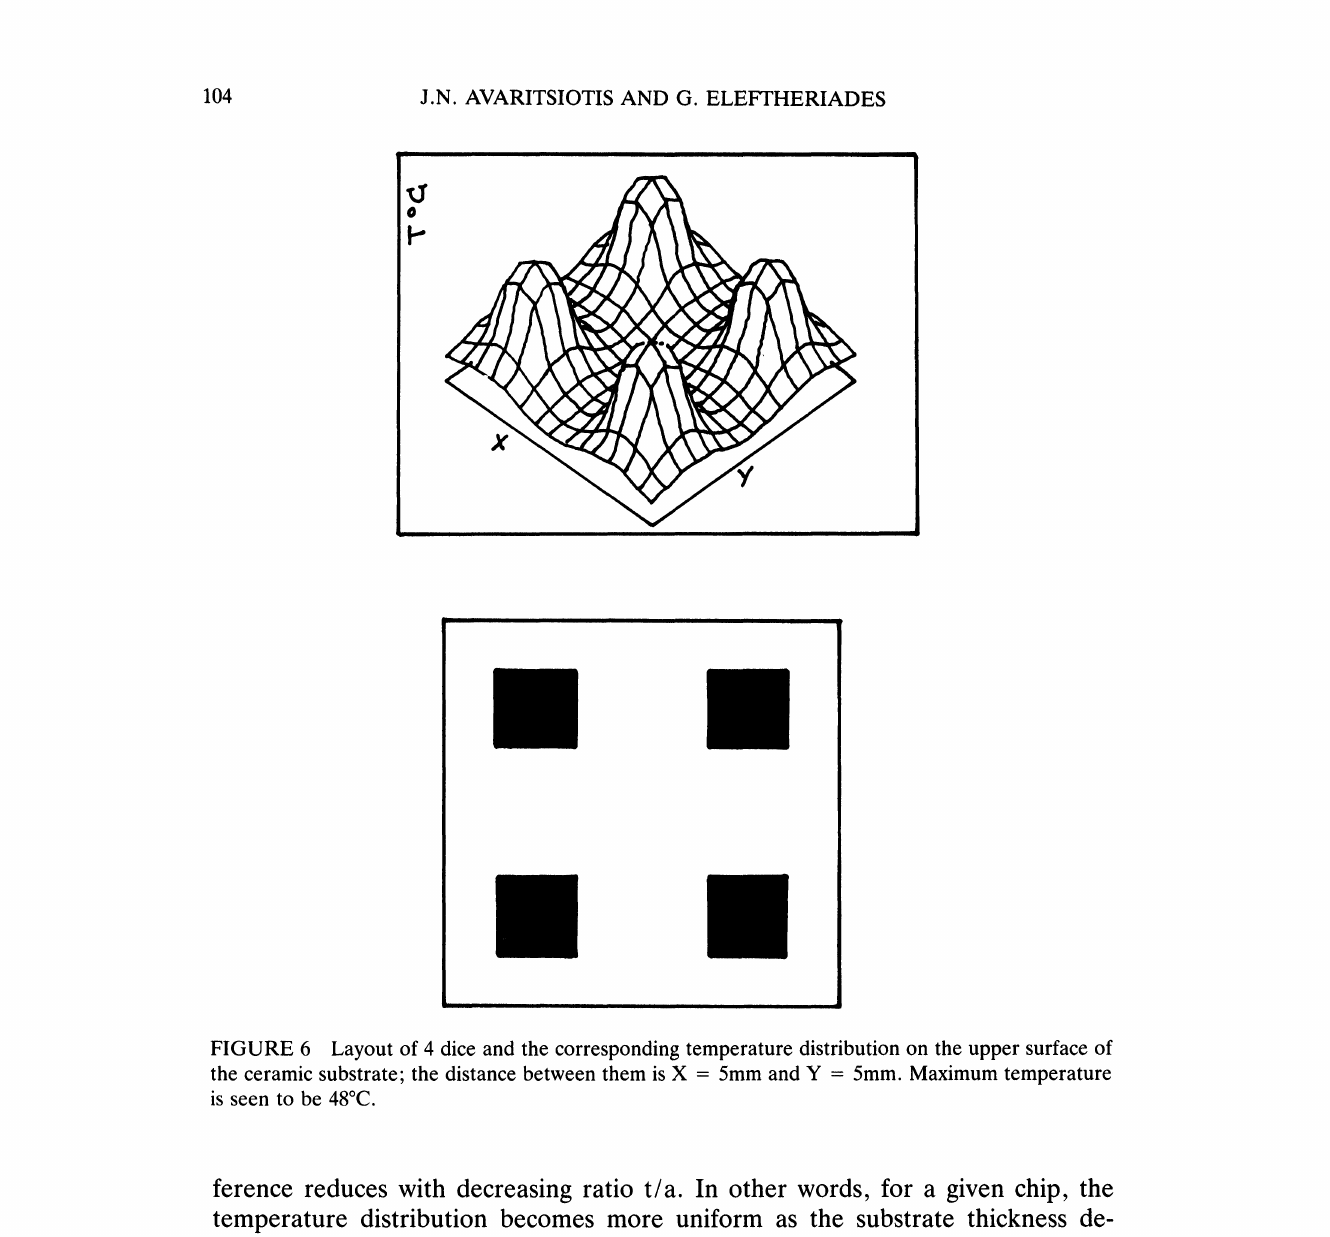
FIGURE 6 Layout of 4 dice and the corresponding temperature distribution on the upper surface of the ceramic substrate; the distance between them is X 5mm and Y 5mm. Maximum temperature is seen to be